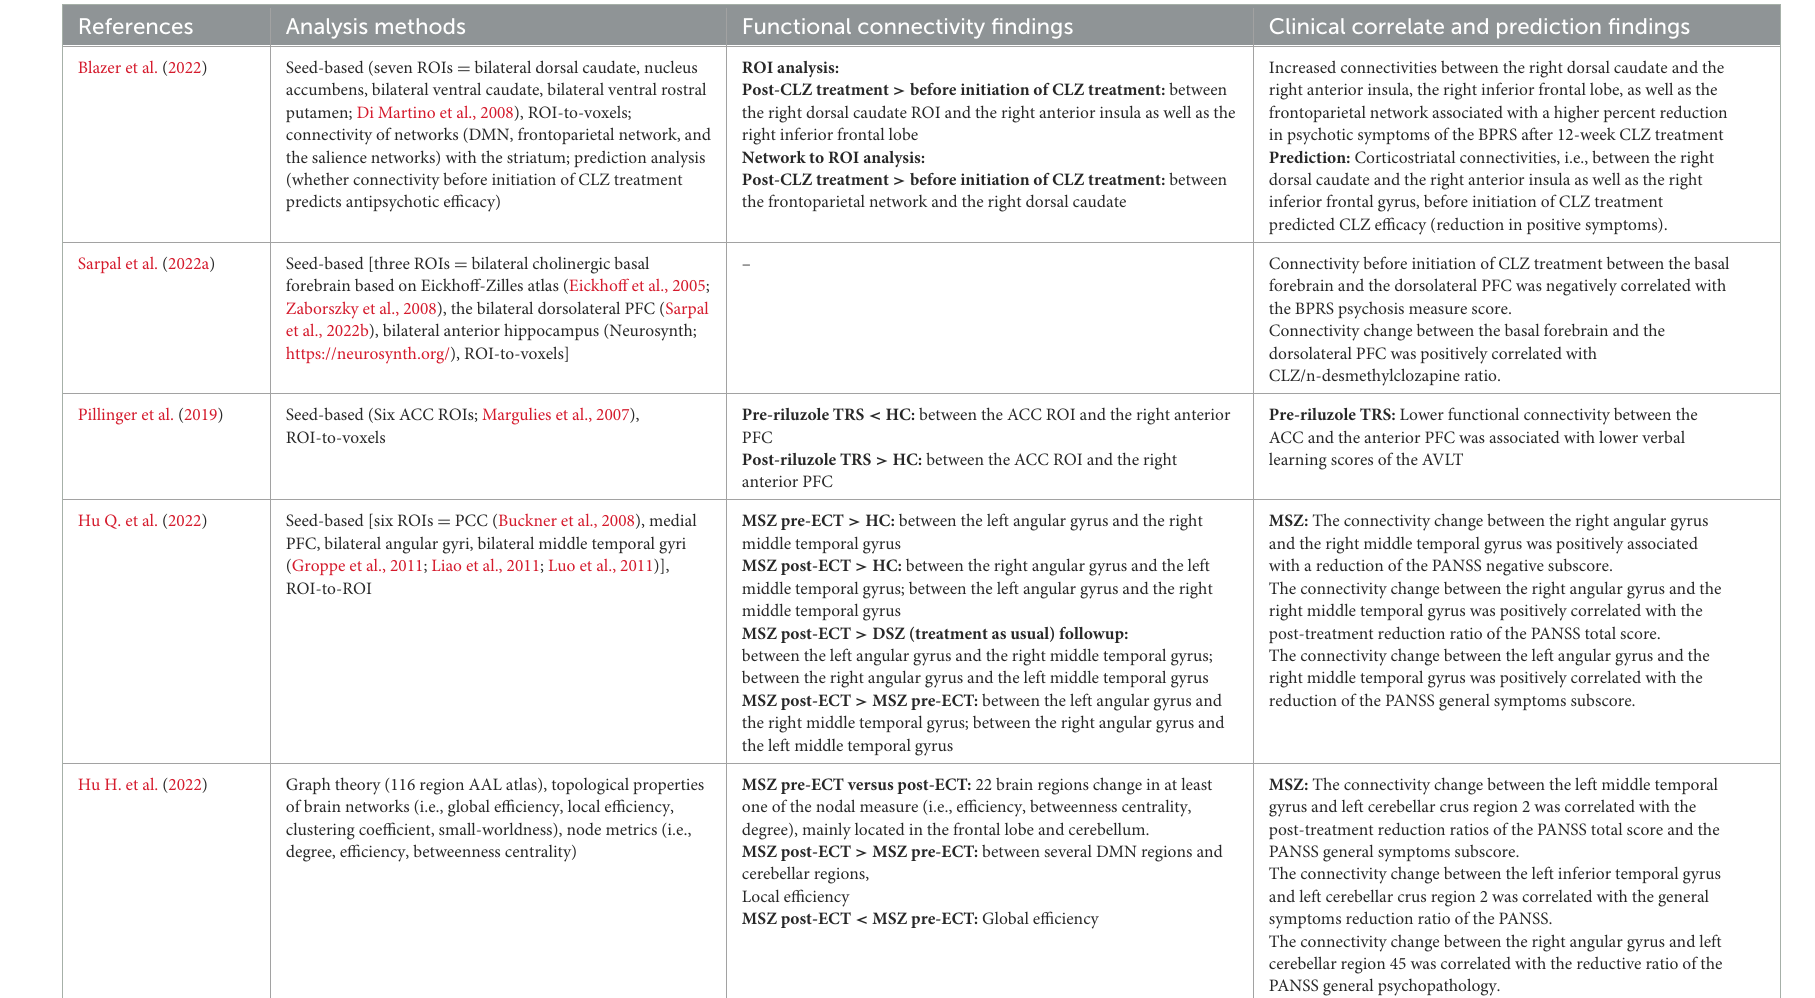
MSZ: The connectivity change between the left middle temporal gyrus and left cerebellar crus region 2 was correlated with the post-treatment reduction ratios of the PANSS total score and the PANSS general symptoms subscore. The connectivity change between the left inferior temporal gyrus and left cerebellar crus region 2 was correlated with the general symptoms reduction ratio of the PANSS. The connectivity change between the right angular gyrus and left cerebellar region 45 was correlated with the reductive ratio of the PANSS general